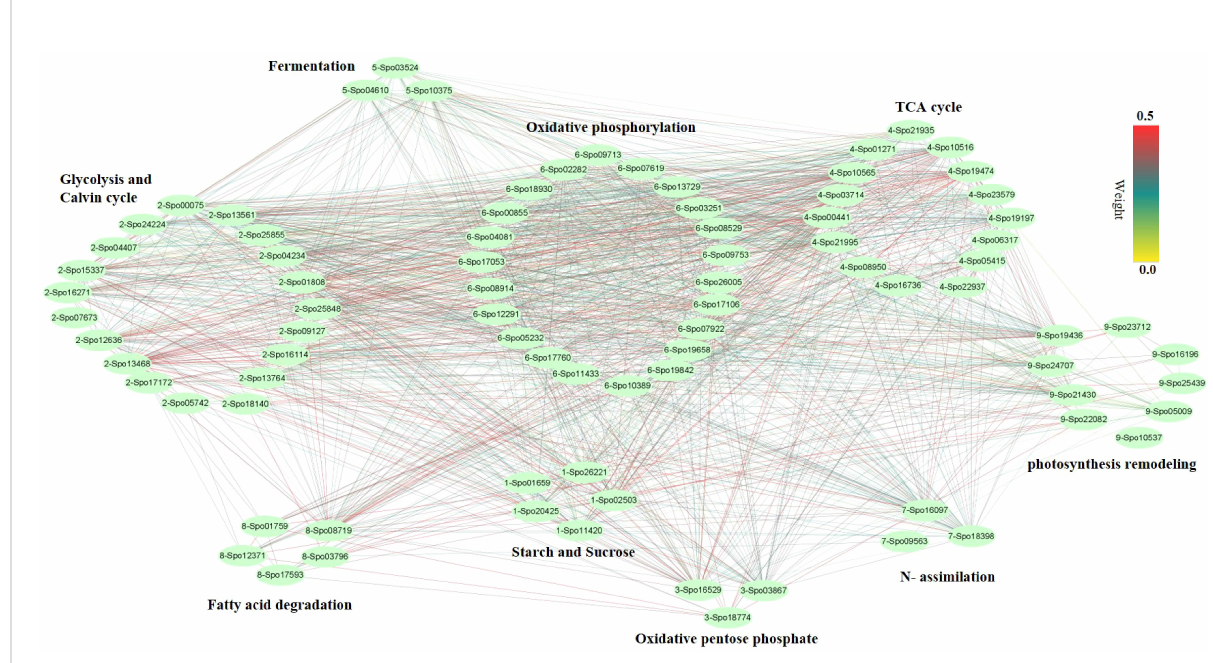
FIGURE 5 Co-expression network analysis of genes from different pathways. The pathways including Starch and sucrose metabolism ( fi ve genes), Oxidative pentose phosphate (three genes), Photosynthesis remodeling (nine genes), Glycolysis and Calvin cycle (19 genes), TCA cycle (15 genes), Fermentation (three genes), N- assimilation (three genes), Oxidative phosphorylation (22 genes), as well as Fatty acid degradation ( fi ve